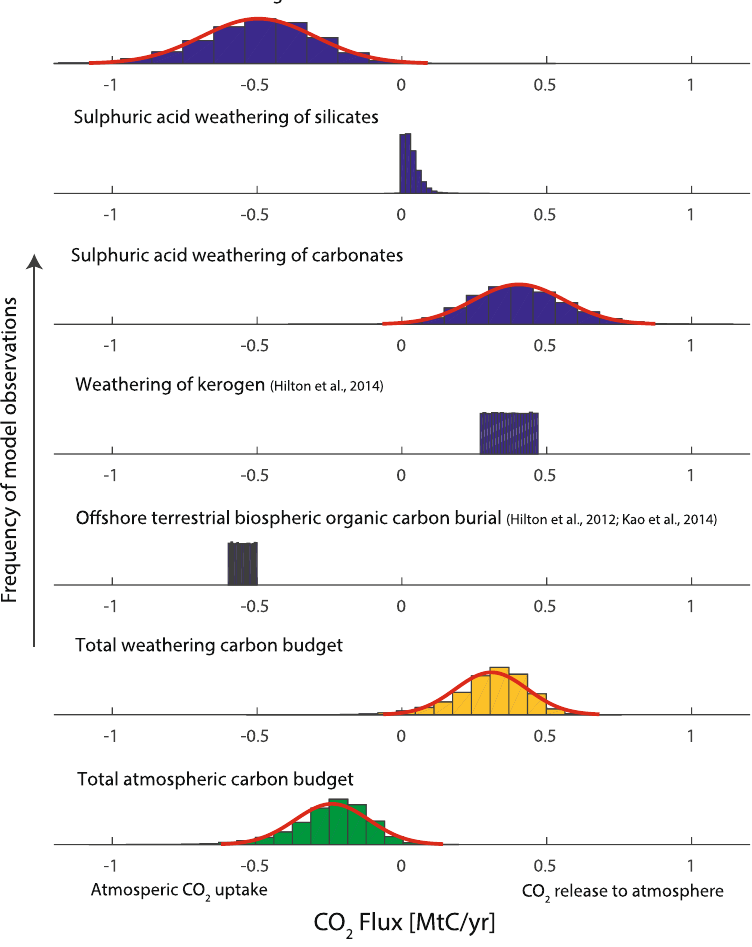
Figure 3. Fluxes of atmospheric CO 2 . Net total CO 2 balance of Taiwan in MtC/yr with positive and negative values representing an atmospheric source and sink, respectively. The effects of CO 2 drawdown and release by mineral weathering (this study) and organic geochemical cycles 29,32,33 are